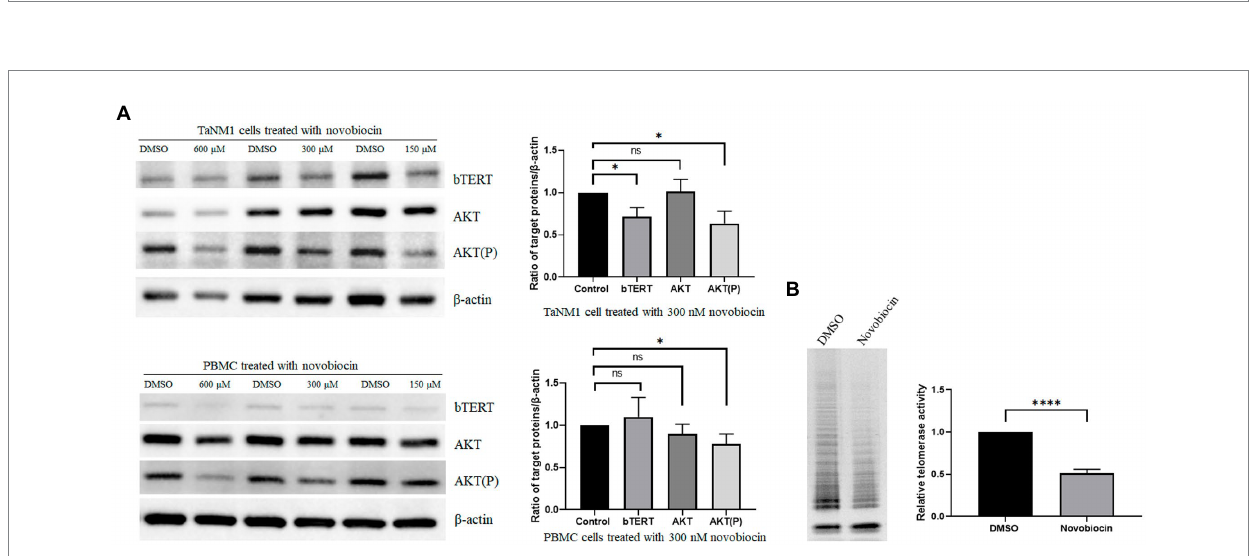
FIGURE 4 Effects of novobiocin on the expression of bTERT and telomerase activity: (A) The TaNM1 and PBMC cells were treated with different concentrations of novobiocin for 18 h. Western blot analysis of protein expression (bTERT, AKT(P), AKT) in TaNM1 and PBMC cells (left). Quantification of Western blot for the target proteins from the cells treated with 300 nM novobiocin using ImageJ software (right). (B) Telomerase activity detection after cells treated with 300 nM novobiocin for 18 h by using TRAP assay (left). Quantification of relative telomerase activity by using ImageJ software (right). The Student’s T -test was used for statistical analysis from the results of three independent experiments. The error bars denote the standard error. ns means no significant difference, * p < 0.05, **** p <